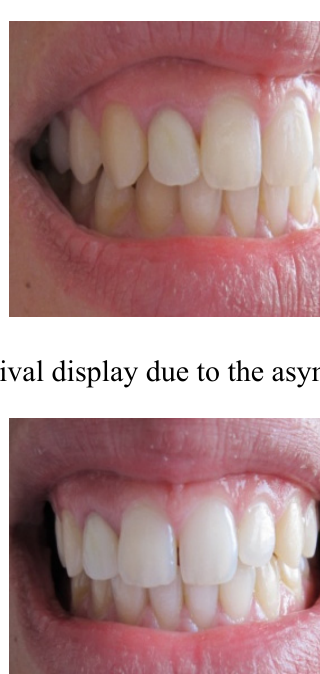
Figure 1. Intra oral view showing the grayish shadow caused by the metal based crown.